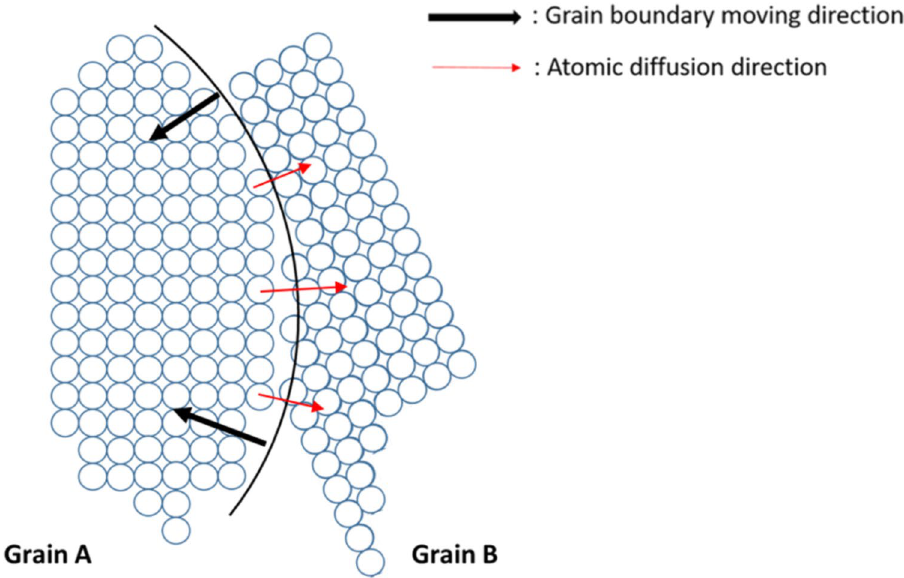
Figure 4. Scheme diagram of grain boundary migration by atomic transition from grain A to grain